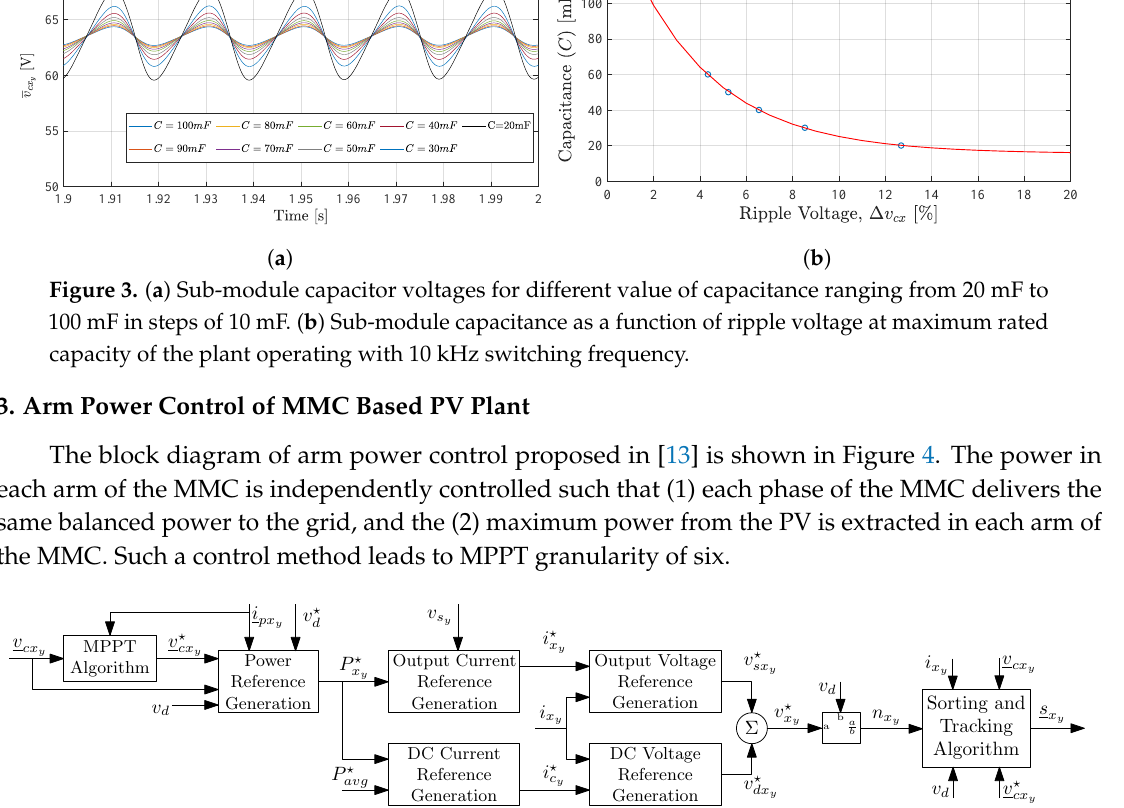
Figure 4. The block diagram of arm power control method of the MMC for PV application proposed in